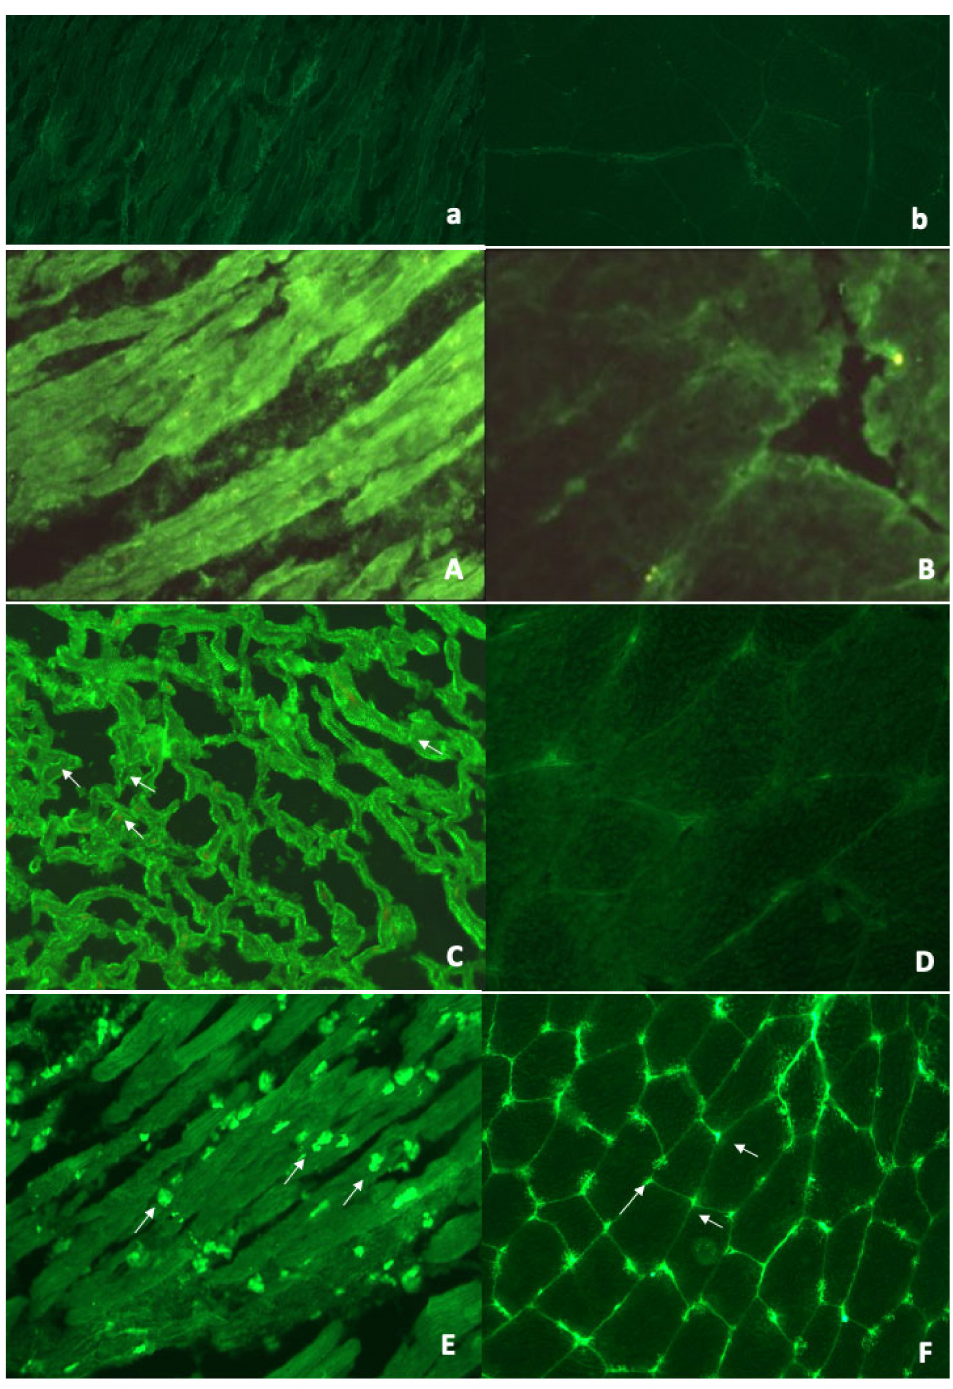
Figure 1. Representative Anti-Heart Auto-antibodies (AHA) and Anti-Intercalated Disk Autoantibodies (AIDA) patterns by indirect immunofluorescence test. Negative AHA, AIDA, and ANA control serum pattern on human heart tissue (panel ( a ), × 200) and on human skeletal muscle (panel ( b ), × 400). Organ-specific AHA pattern : panel ( A ) on human heart tissue: strong diffuse cytoplasmic staining of cardiac myocytes (organ-specific AHA pattern) ( × 400); panel ( B ) ( × 400) on human skeletal muscle tissue: negative. Organ-specific AHA and AIDA pattern : panel ( C ) strong linear staining of the intercalated disks (AIDA pattern) (white arrows) and associated organ-specific AHA diffuse and fine striational pattern ( × 400); panel ( D ) ( × 400) on human skeletal muscle tissue: negative. Organ-specific AHA and ANA pattern : panel ( E ) on human heart tissue: strong diffuse cytoplasmic staining of cardiac myocytes (organ-specific AHA pattern) and associated antinuclear antibody (ANA) (white arrows) ( × 200); panel ( F ) ( × 200) on human skeletal muscle tissue: negative for AHA and positive for ANA (white arrows). Note the intracellular location of ANA on human heart and the peripheral location of ANA on skeletal